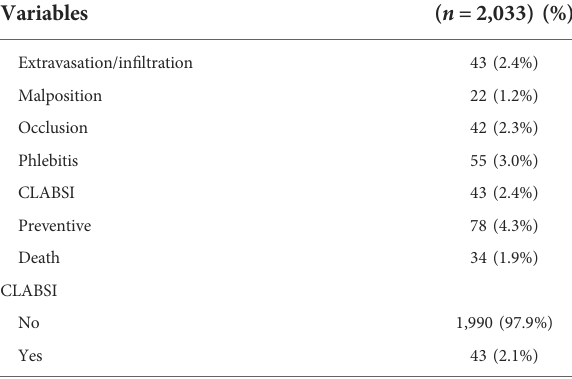
TABLE 2 Clinical variables of the study